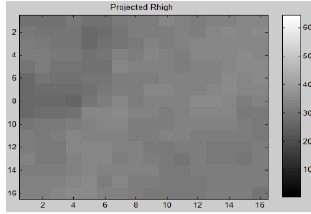
Table 2. Chi-square test for the first